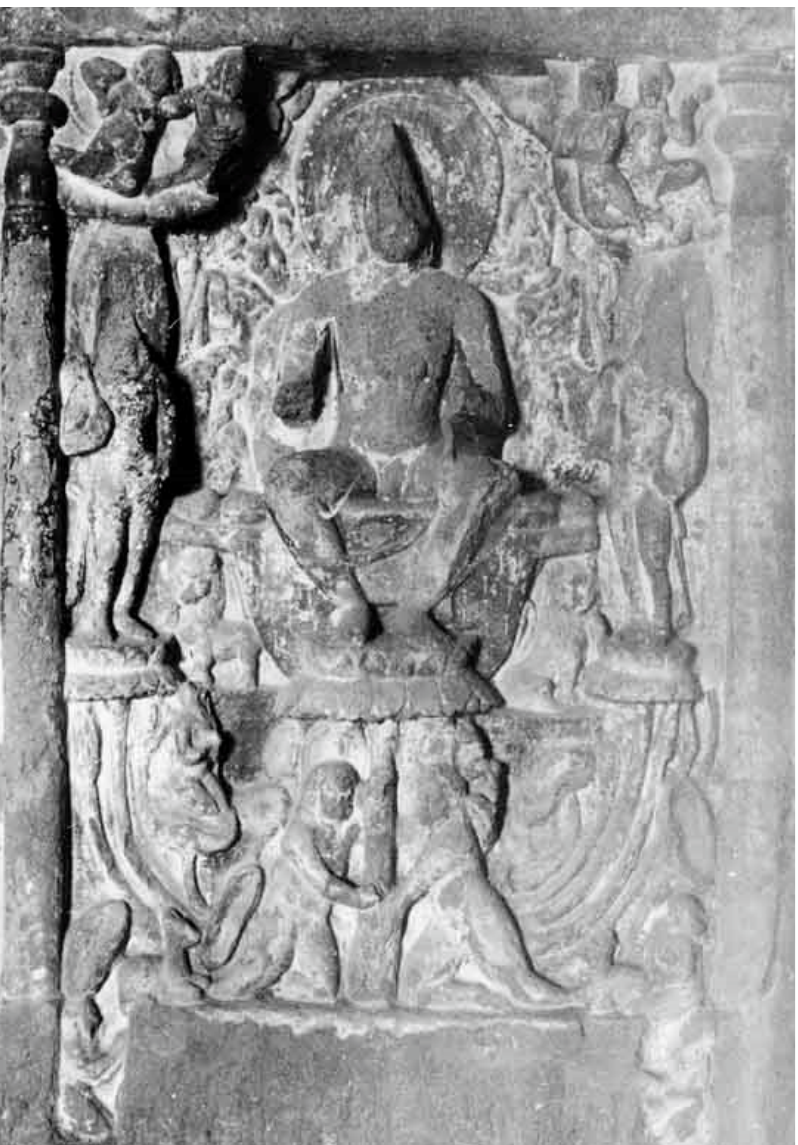
Figure 9. Intrusive panel with painted inscription from Aja ṇṭ ā Cave 22, ca. 478–480 CE (Courtesy of AIIS # 96804).